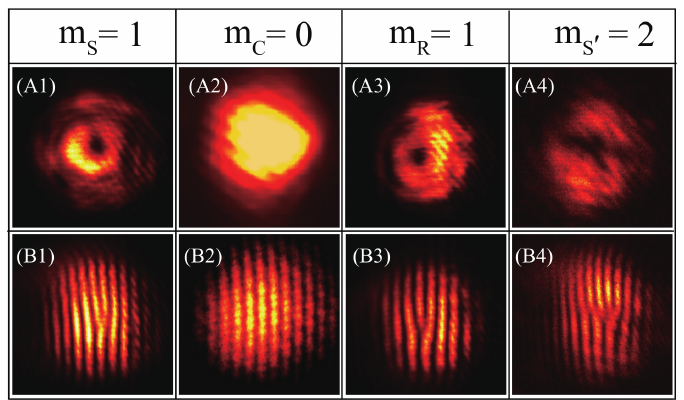
Figure 7. Mode conversion of the optical vortexes achieved through the EIT-based light pulse storage and retrieval process. Here, m S = m R = 1 and m C = 0, and the OTC of the retrieved output signal pulse is m S (cid:48) = 2, in good accordance with Equation (6). The first row shows the intensity distributions of the respective interacting beams, and the second row depicts the interference fringes of the corresponding beams with the plane wave. The forklike interference fringes indicate the OTCs carried by each optical vortex beam. Figure partially adapted from reference